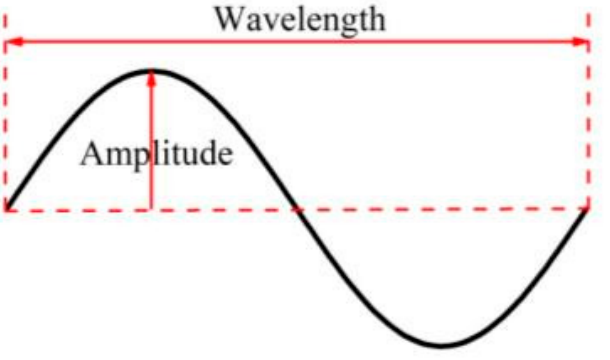
Figure 8. Schematic illustration of geometry parameters of the grain boundary.